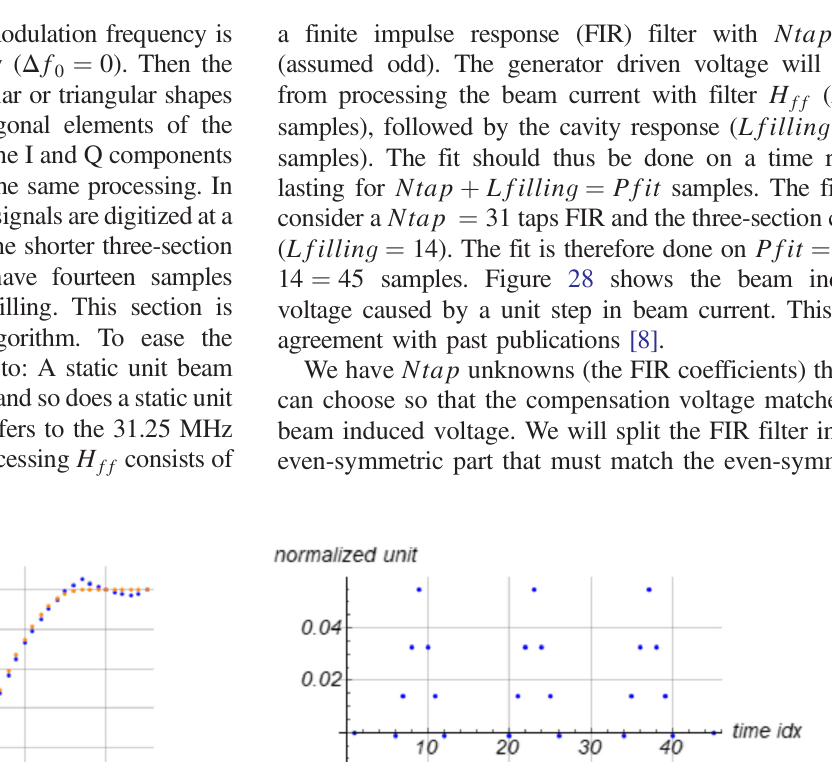
FIG. 30. Compensation voltage due to the feedforward (blue) and beam induced voltage (orange). Left: voltage caused by the even- symmetric impulse response compared to the one caused by the real part of cavity impedance (perfect superposition). Right: voltage caused by the odd-symmetric impulse response compared to the one caused by the imaginary part of cavity impedance.